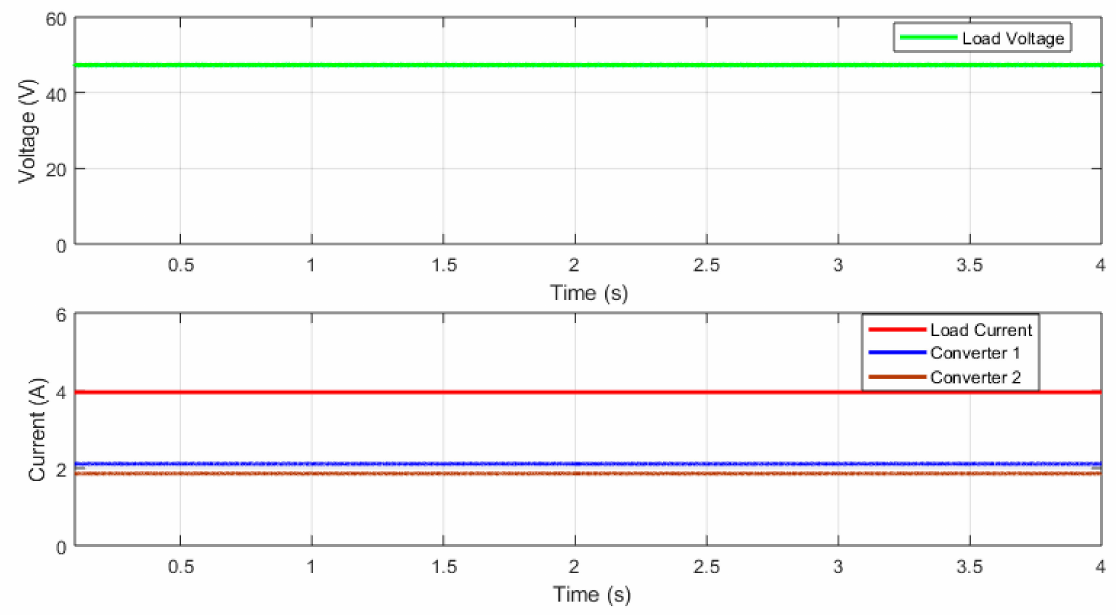
Figure 9. Simulation results for different cable resistance for novel droop control: load voltage, converter output currents and load